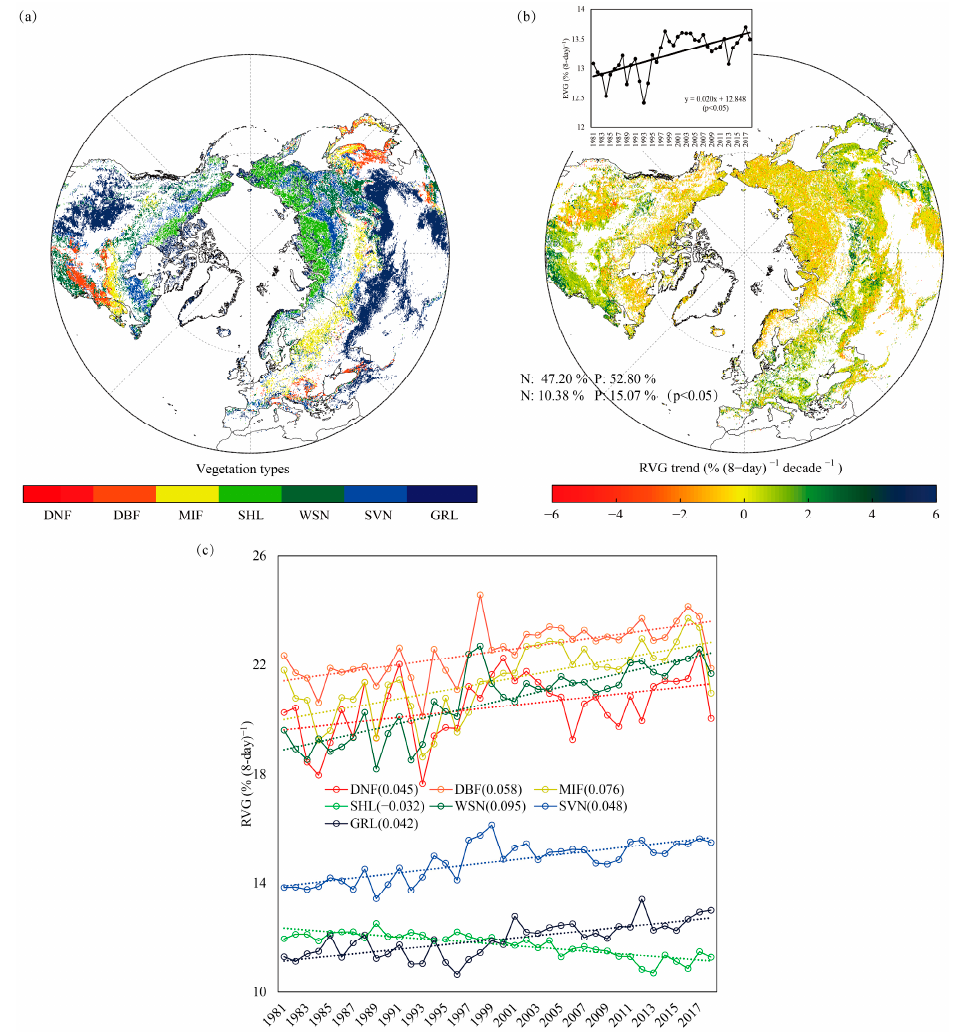
Figure 1. Spatial distribution of ( a ) seven vegetation types including deciduous needleleaf forests (DNF), deciduous broadleaf forests (DBF), mixed forests (MIF), shrublands (SHL), woody savannas (WSN), savannas (SVN), and grasslands (GRL); ( b ) RVG trends over northern extratropics (the area-weighted average RVG and its trend are marked in the upper left corner, and the proportion of positive and negative trends is shown in the lower left corner. N and P represent a negative trend and a positive trend, respectively); ( c ) RVG trends across different biomes during the period 1981–2018.